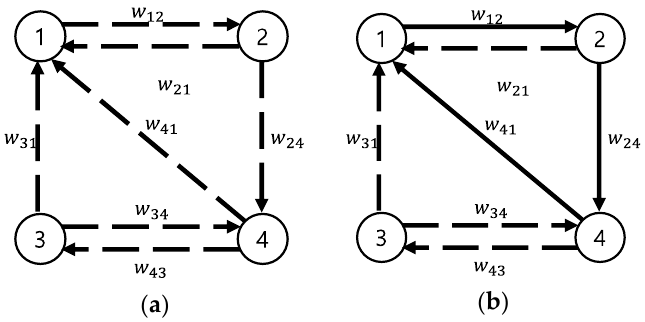
Figure 2. Example of ( a ) a kidney exchange program (KEP) graph and ( b ) three-pair kidney exchanges.